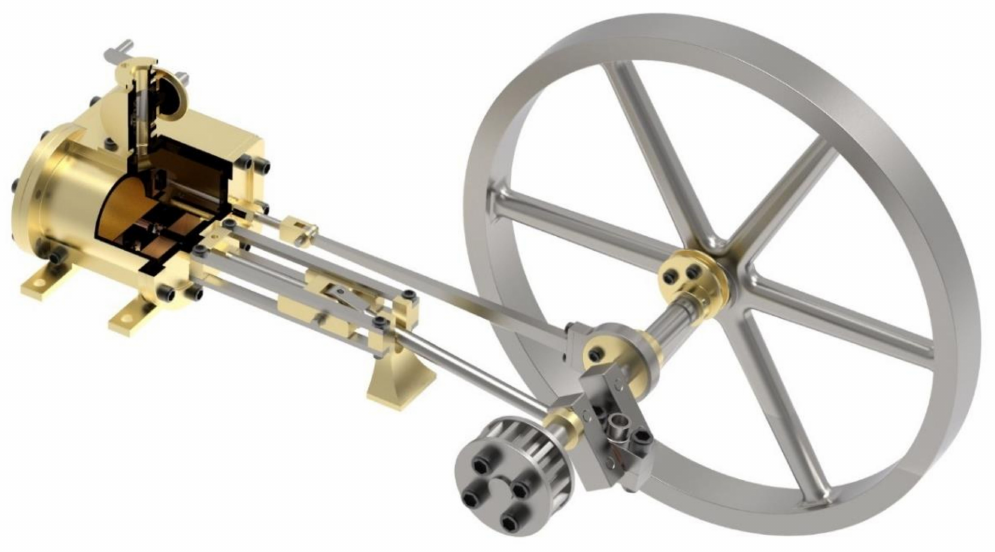
Figure 13. Steam engine assembly.